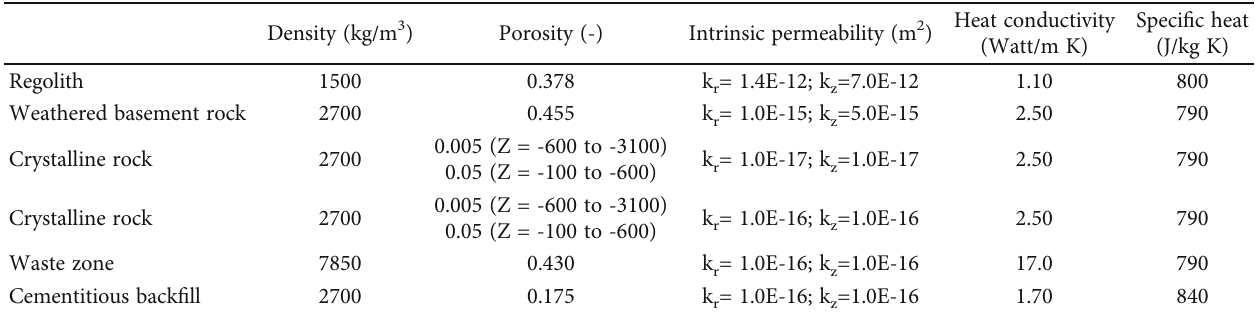
Table 1: Petrophysical properties of model layers. In all formations — except the regolith — isotropy in permeability is assumed ( k Other properties are also assumed isotropic. Case numbers refer to simulation scenarios. Data source is from